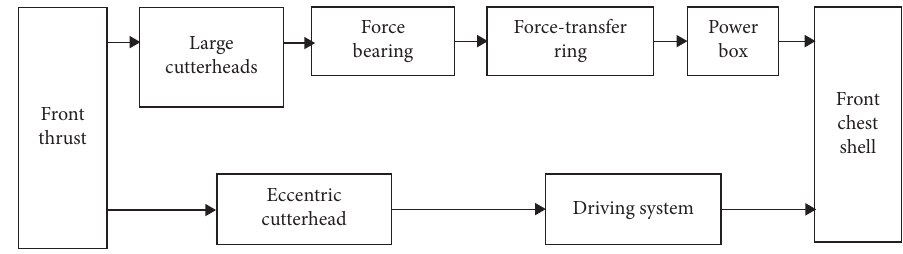
Figure 4: Transmission of front thrust.